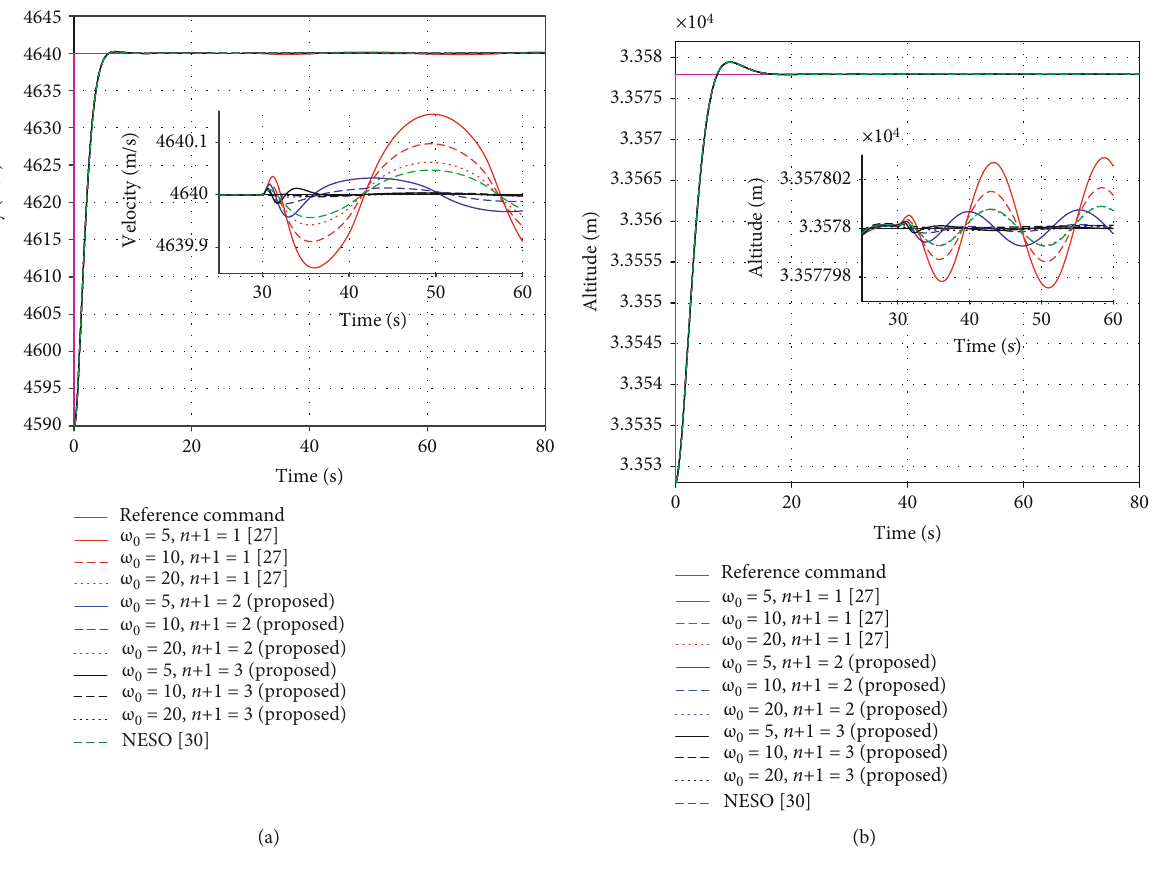
Figure 5: The response curves of NSV: (a) velocity channel; (b) altitude